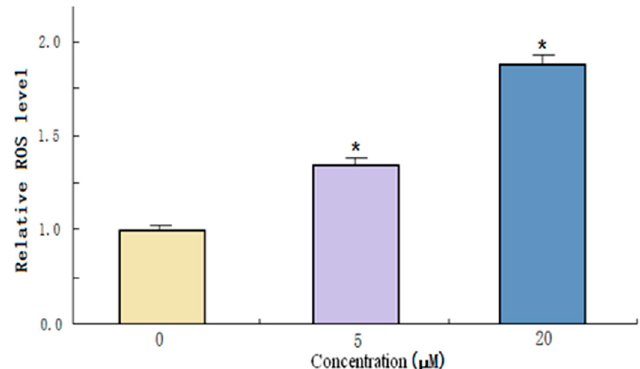
Figure 6. The intracellular ROS (reactive oxygen species) level of HepG2 cells was increased by treating with different concentrations of probe 8d . Data are presented as the mean ± SD of three experiments. * p < 0.05.